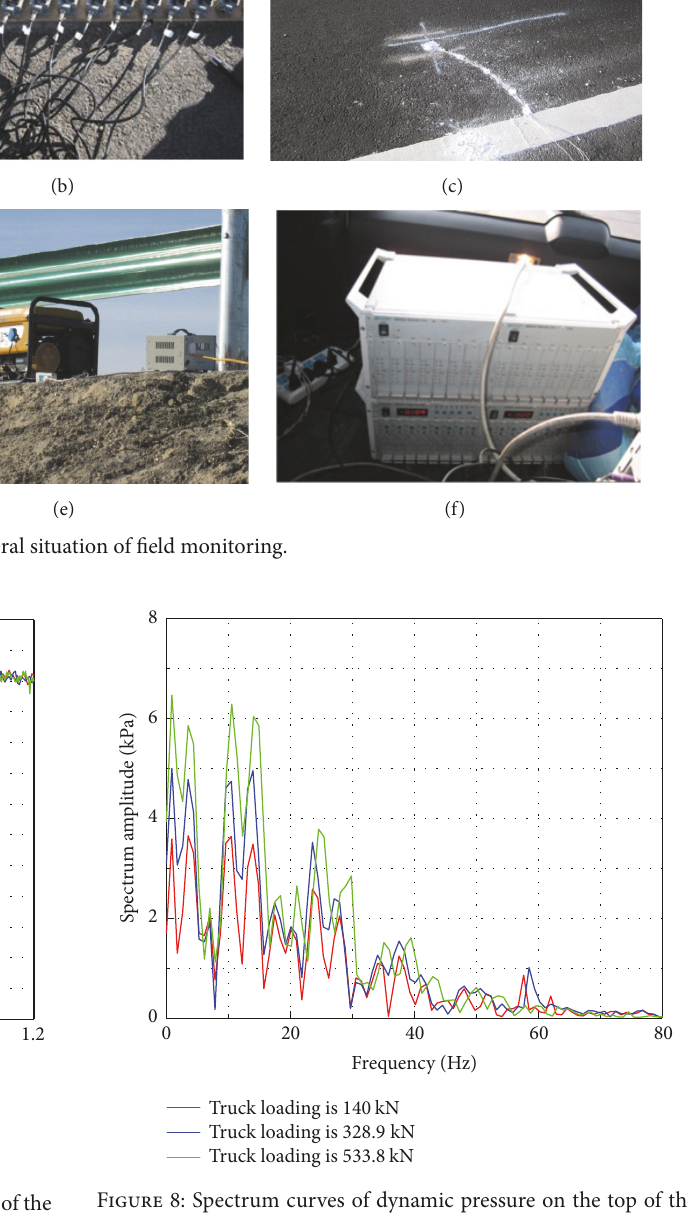
Figure 7: Time history curves of dynamic pressure on the top of the base course under different truck loadings.